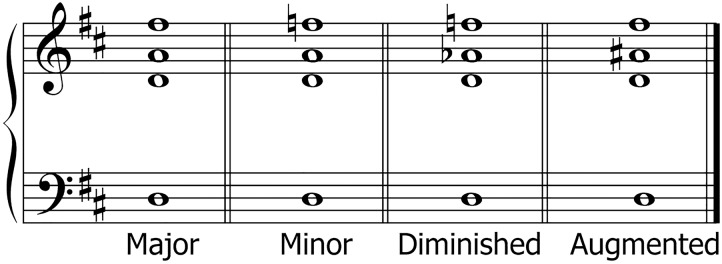
Musical scores for the four different chords used in experiments 1 and 2.